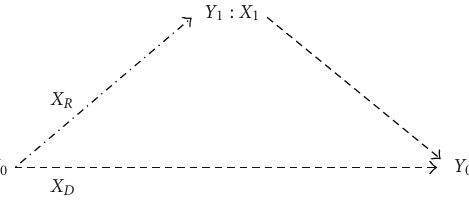
Figure 5: A class of orthogonal relay